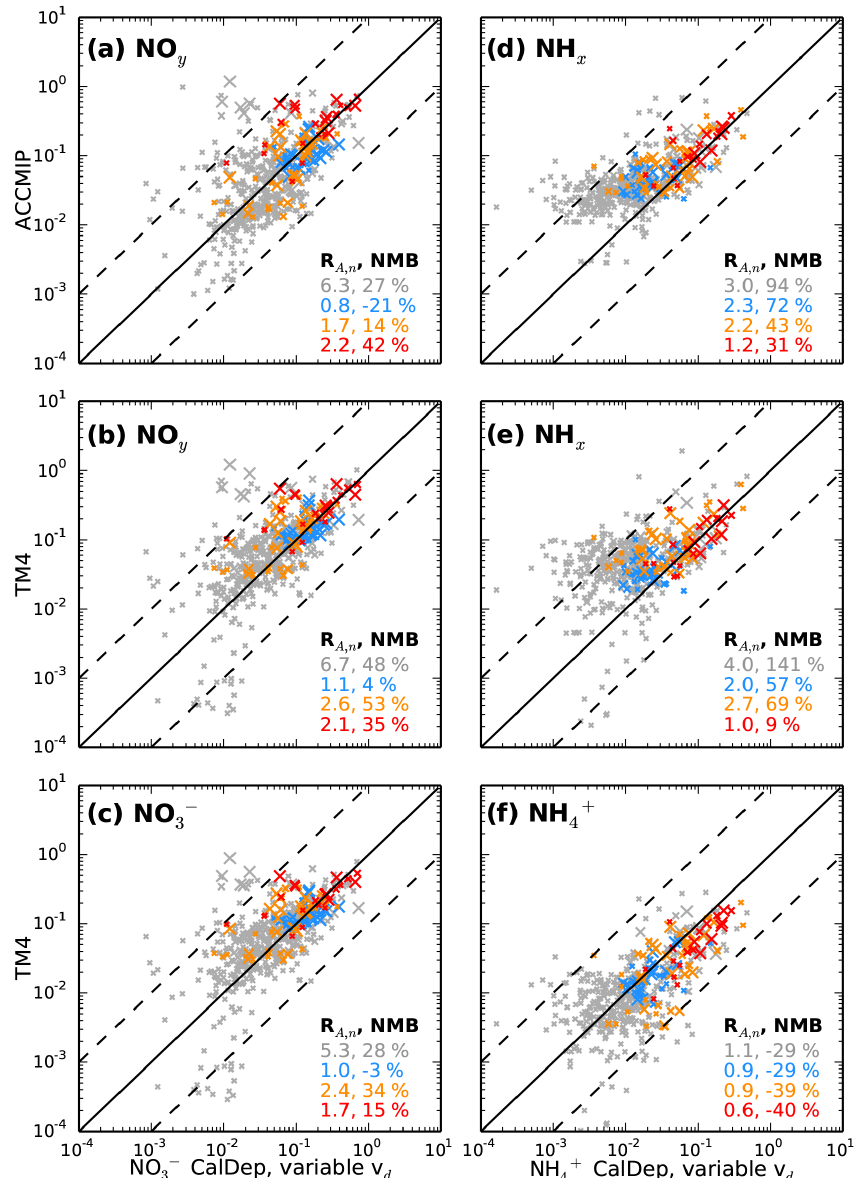
Figure 7. Scatter plots comparing dry deposition fluxes (mg Nm − 2 d − 1 ) of (a–c) NO − database with corresponding fluxes from model output. Panels represent comparisons to (a) NO y from ACCMIP, (b) NO y from TM4, (c) NO − from TM4, (d) NH x from ACCMIP, (e) NH x from TM4 and (f) NH + 3 Explanations of marker sizes and colours are given in the legend for Fig.